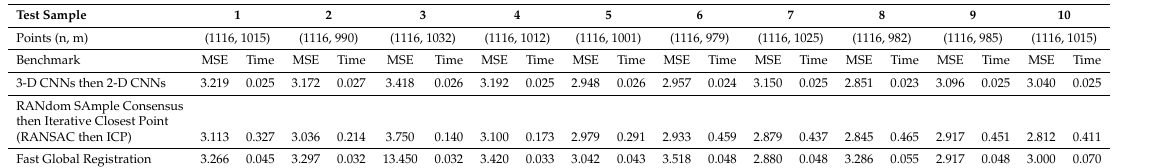
Table 1. The comparisons about mean squared error (MSE) and computation time of “Bunny” data for test samples from 1 to